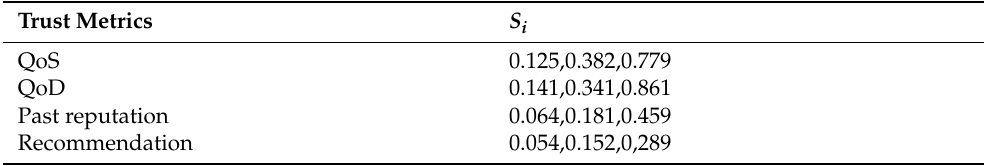
Table 18. FSE ( S i ) value for trust metrics.